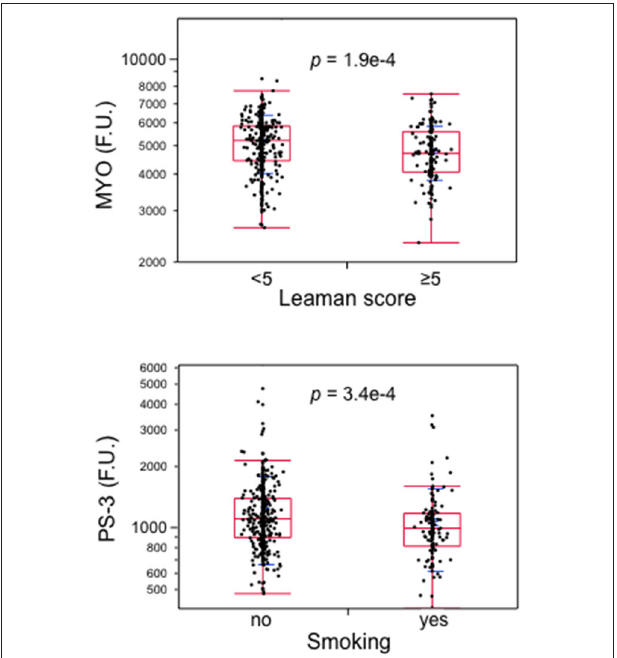
FIGURE 3 | Ability of the 12 proteins selected from Table 3 to predict groups as tested by the area-under-curve (AUC) of the receiver operating characteristics (ROC) functions. Protein signals were standardized to the median and log-transformed. CAD, coronary artery disease; RF, risk factor.